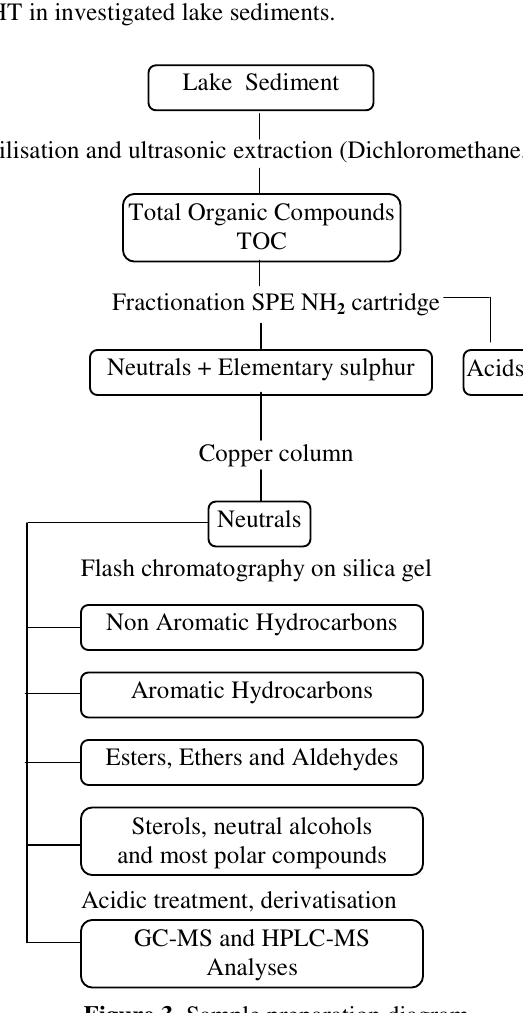
Figure 3. Sample preparation